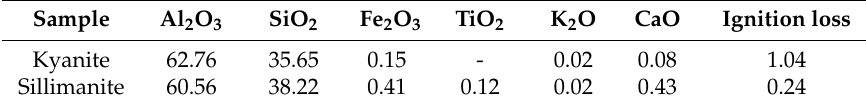
Table 1. Chemical components of kyanite and sillimanite (%).